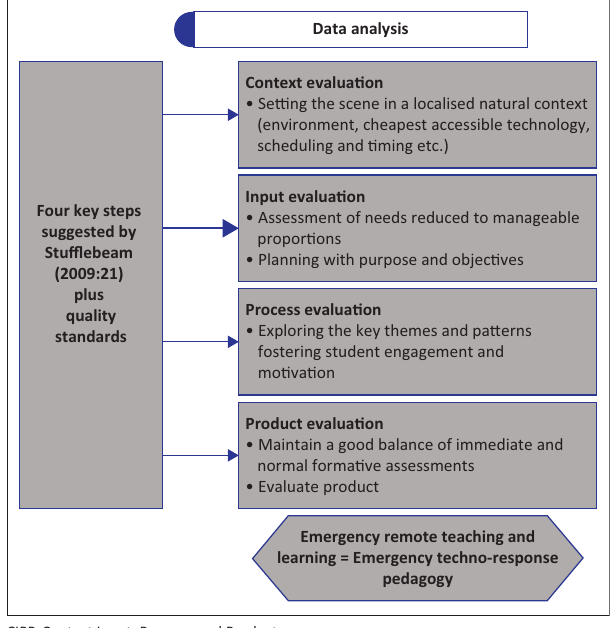
FIGURE 2: The CIPP model guiding the conceptual